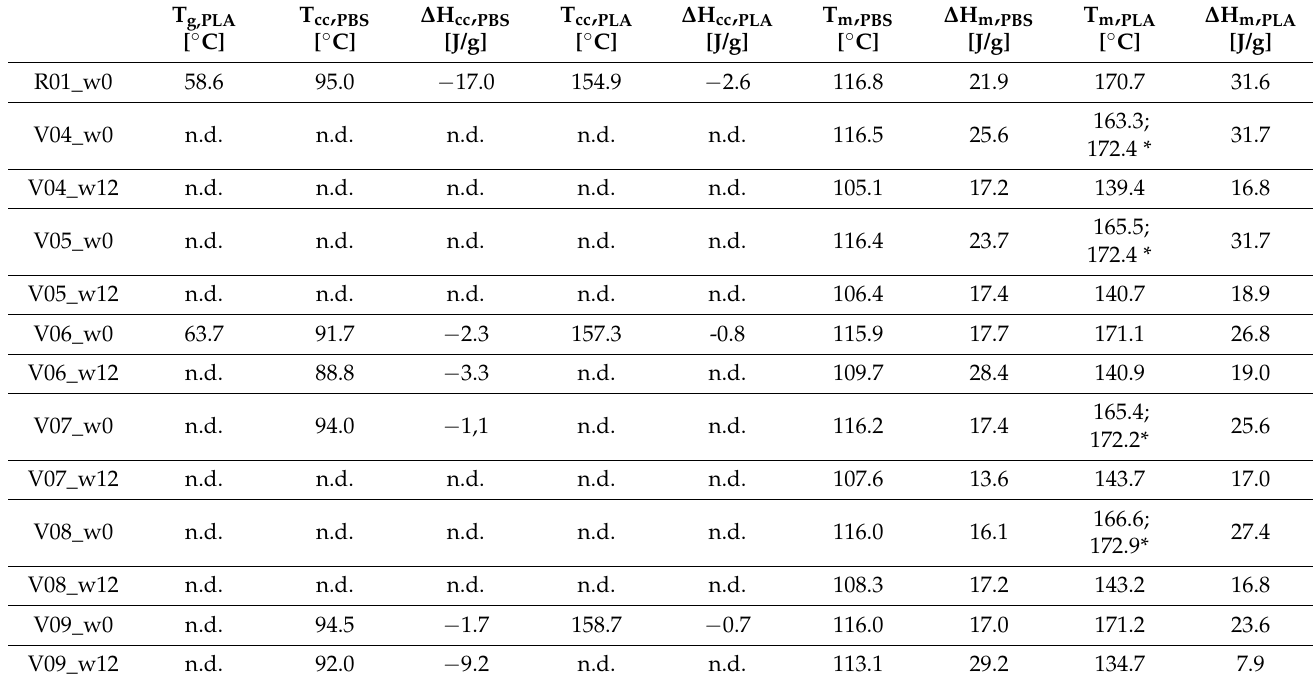
Table 3. Thermal values of mineral-filled blend systems before and after